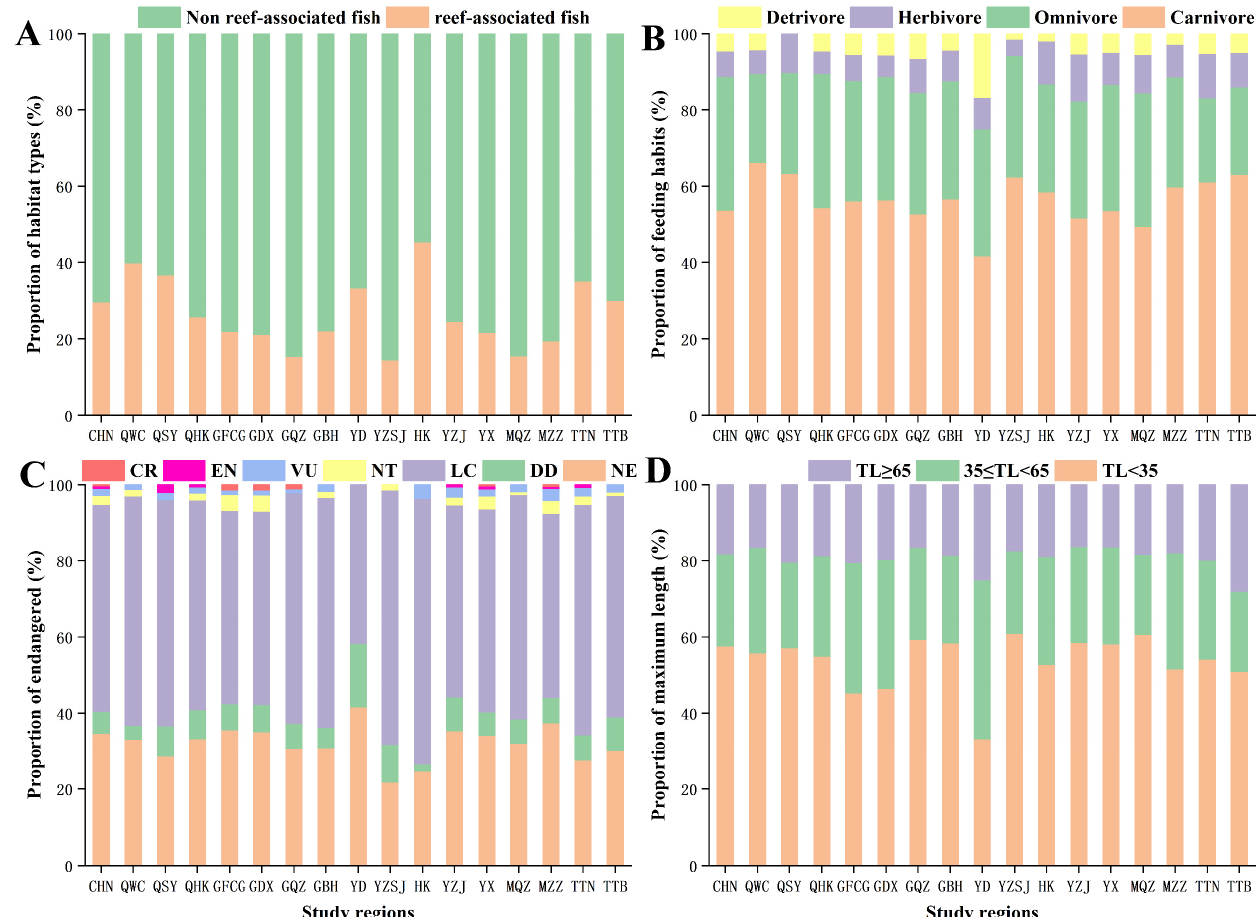
Figure 3. Distribution characteristics of fish community structure in different regions. ( A ) Habitat types of fishes in different regions. ( B ) Feeding habits of fishes in different regions. ( C ) Endangered of fishes in different regions. ( D ) Maximum length of fishes in different regions. CHN: CHINA;